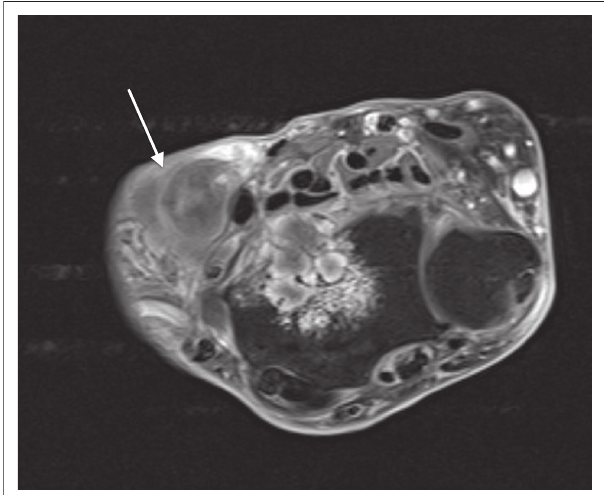
FIGURE 4: Axial T1-weighted fat-saturated image post intravenous gadolinium shows intense, predominantly peripheral, enhancement with central low T1 signal in the thenar mass (white arrow) and the radial erosion .